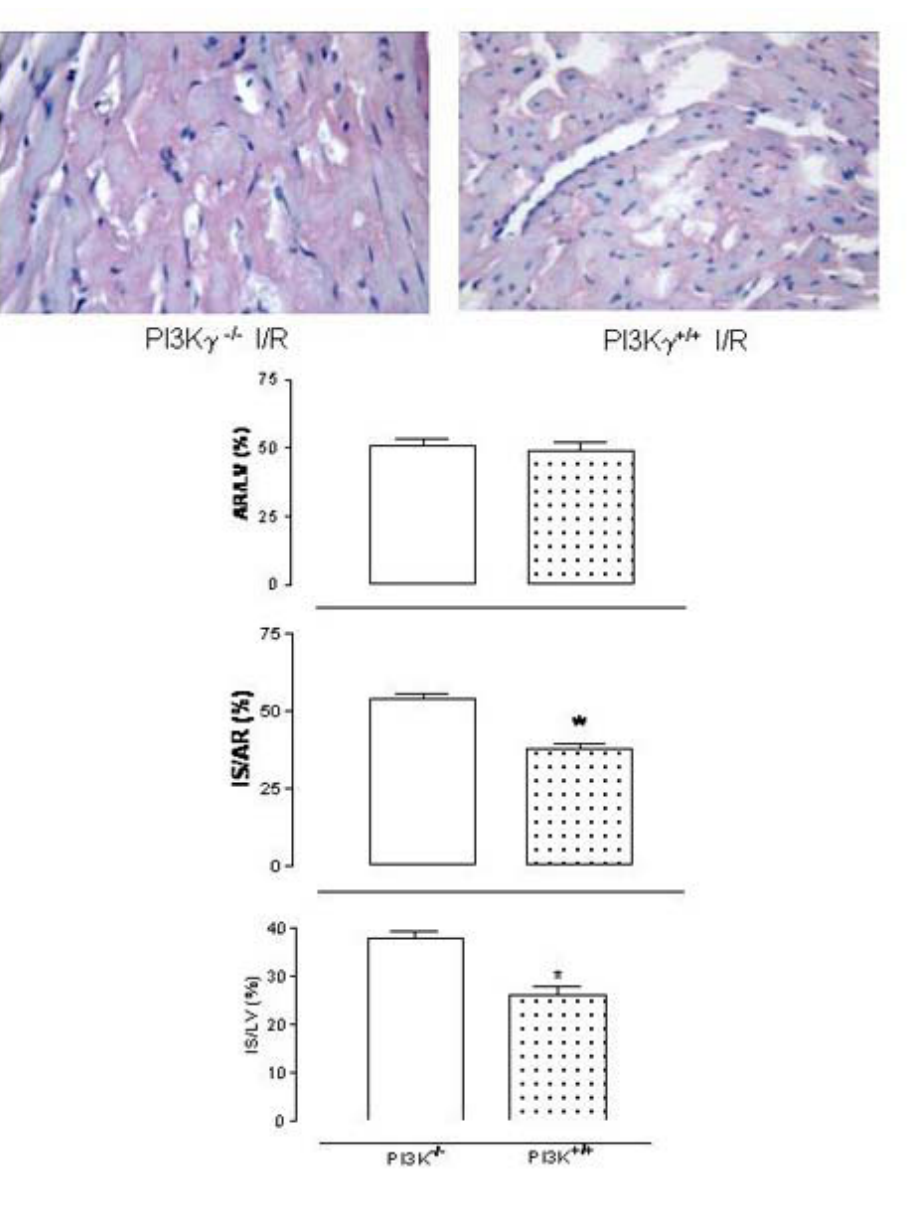
Figure 1. The absence of PI3K γ increases the severity of the myocardial damage induced by ischemia/reperfusion. This was induced by the occlusion of the left anterior descending coronary artery for 25 min followed by 2 h of reperfusion. The infarct size is expressed as a function of the area at risk [ 25 ] . PI3K γ -/- mice and relative wild type littermates were treated intravenously with saline (1 ml/kg). Data are mean ± SE of n=10 mice per group.* P<0.01 vs. respective PI3K γ -/- mice. IS/AR (Infarct Size/Area at Risk), AR/LV (Area at risk/Left Ventricle) IS/LV (Infarct Size/ Left Ventricle). Panel A) Representative cardiac histological sections; Panel B) Infarct size as